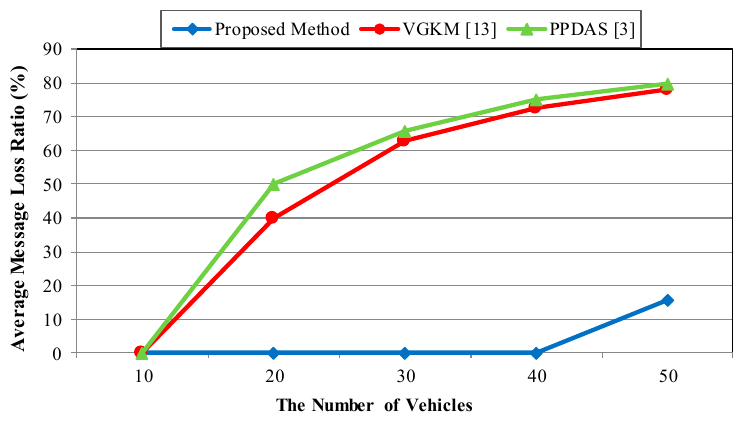
Figure 22. Average message loss ratio vs. number of vehicles.